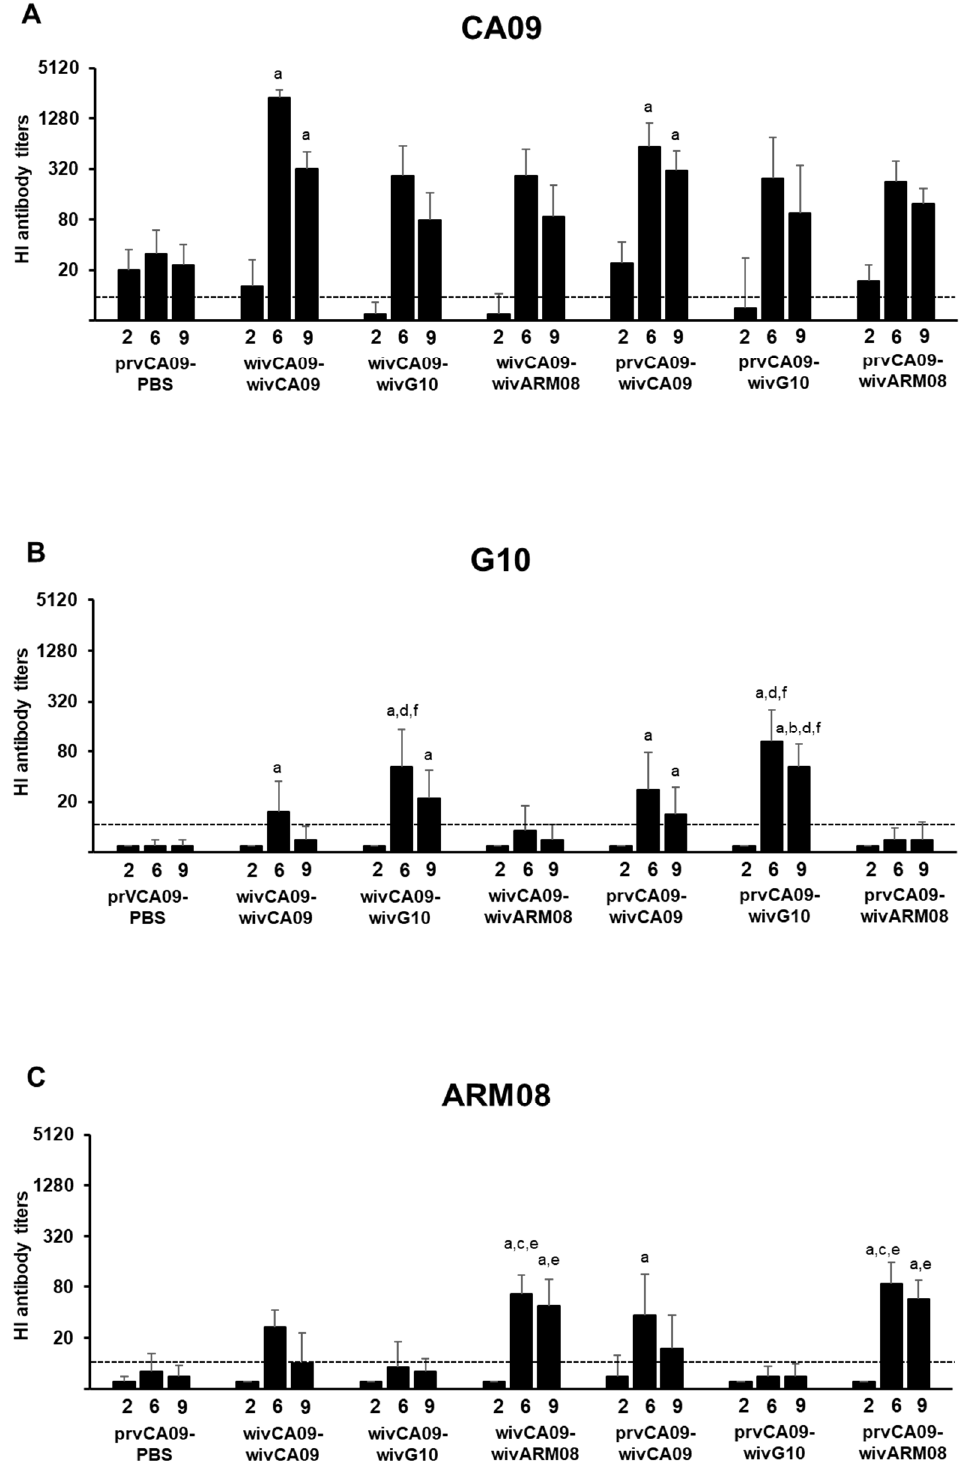
Figure 2. Geometric mean hemagglutination inhibition antibody titers against vaccine strains CA09 ( A ), G10 ( B ), and ARM08 ( C ). Titers were determined at 2 weeks post-vaccination 1 and 2 and at challenge (weeks 2, 6, and 9). The vaccine groups are described on the x-axis. The dotted line indicates the detection limit (10). Mock-vaccinated control pigs tested negative in all assays and were not shown. Letters indicate significant differences to prvCA09–PBS (a), wivCA09–wivCA09 (b), wivCA09–wivG10 (c), wivCA09–wivARM08 (d), prvCA09–wivG10 (e), prvCA09–wivARM08 (f) in the Kruskall–Wallis test ( p ≤ 0.05). See Figure 1 for full names of the virus